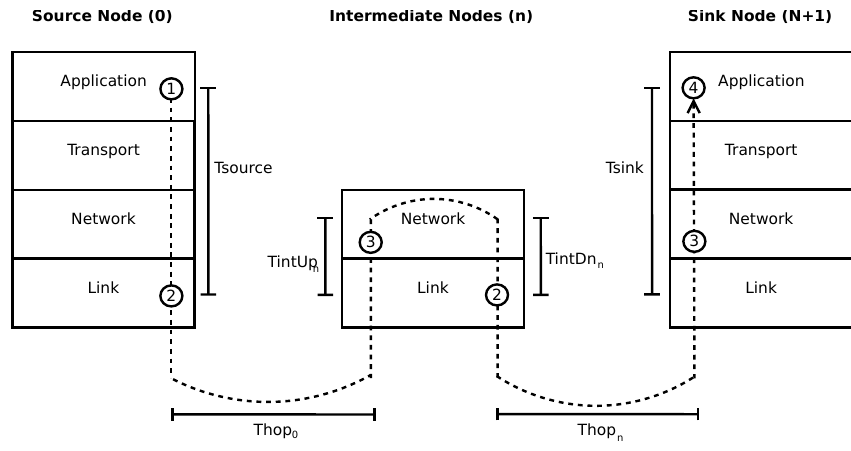
Figure 4. Time synchronization time retrieval Fig. 4: Time synchronisation time retrieval points